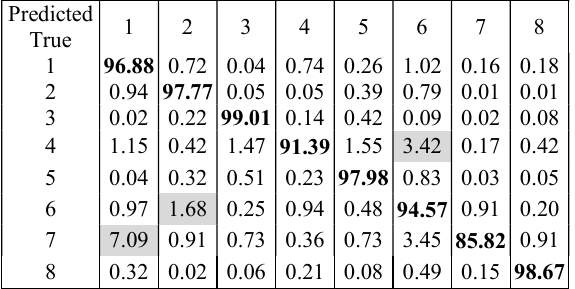
Table 9. Confusion matrix normalized by reference (in %) showing the classification result of PN